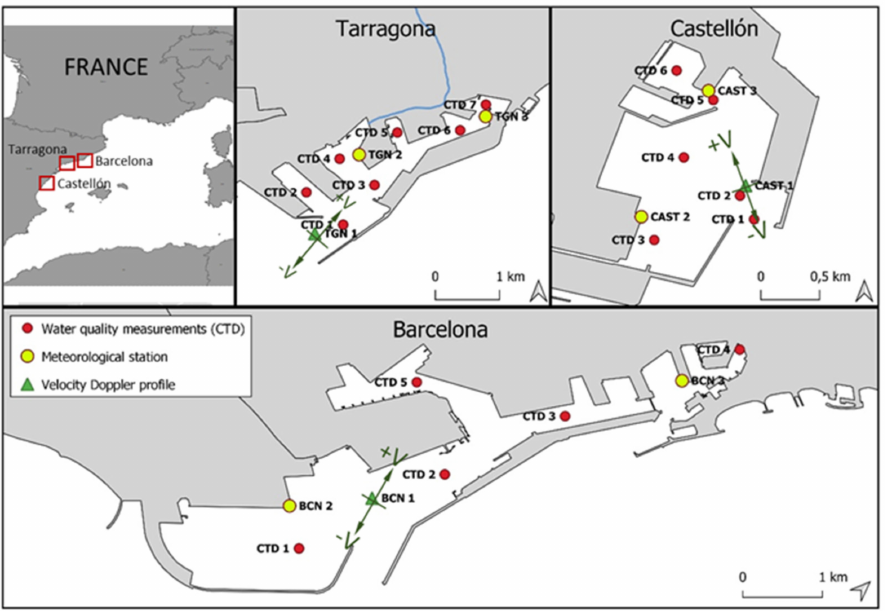
Figure 1. Maps of harbour case studies. Left upper inset shows the ports’ locations. The other insets show the layout of Tarragona, Castell ó n, and Barcelona Ports. Coloured and numbered circles indicate locations of measuring sites. Green triangles correspond to current metre deployments, yellow dots indicate meteorological and sea-level stations, and red dots show the location of CTD (Conductivity, Temperature y Depth)